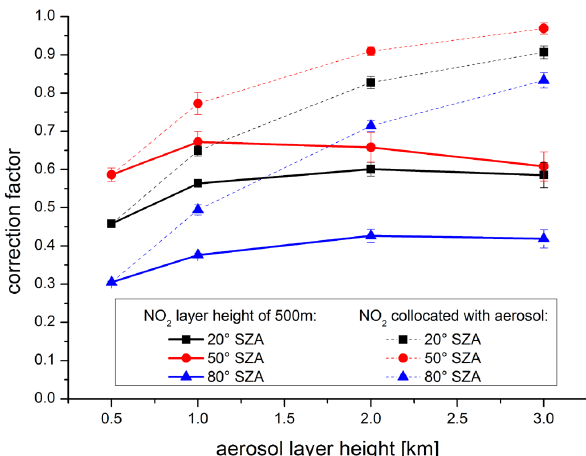
Fig. 5. Correction factors in the case of a fixed NO 2 layer height of 500m and a more extended aerosol layer up to 3000m (thick lines) for 20 ◦ , 50 ◦ and 80 ◦ SZA for the MCMA-2006 case study. The dotted lines represent the original scenario of collocated